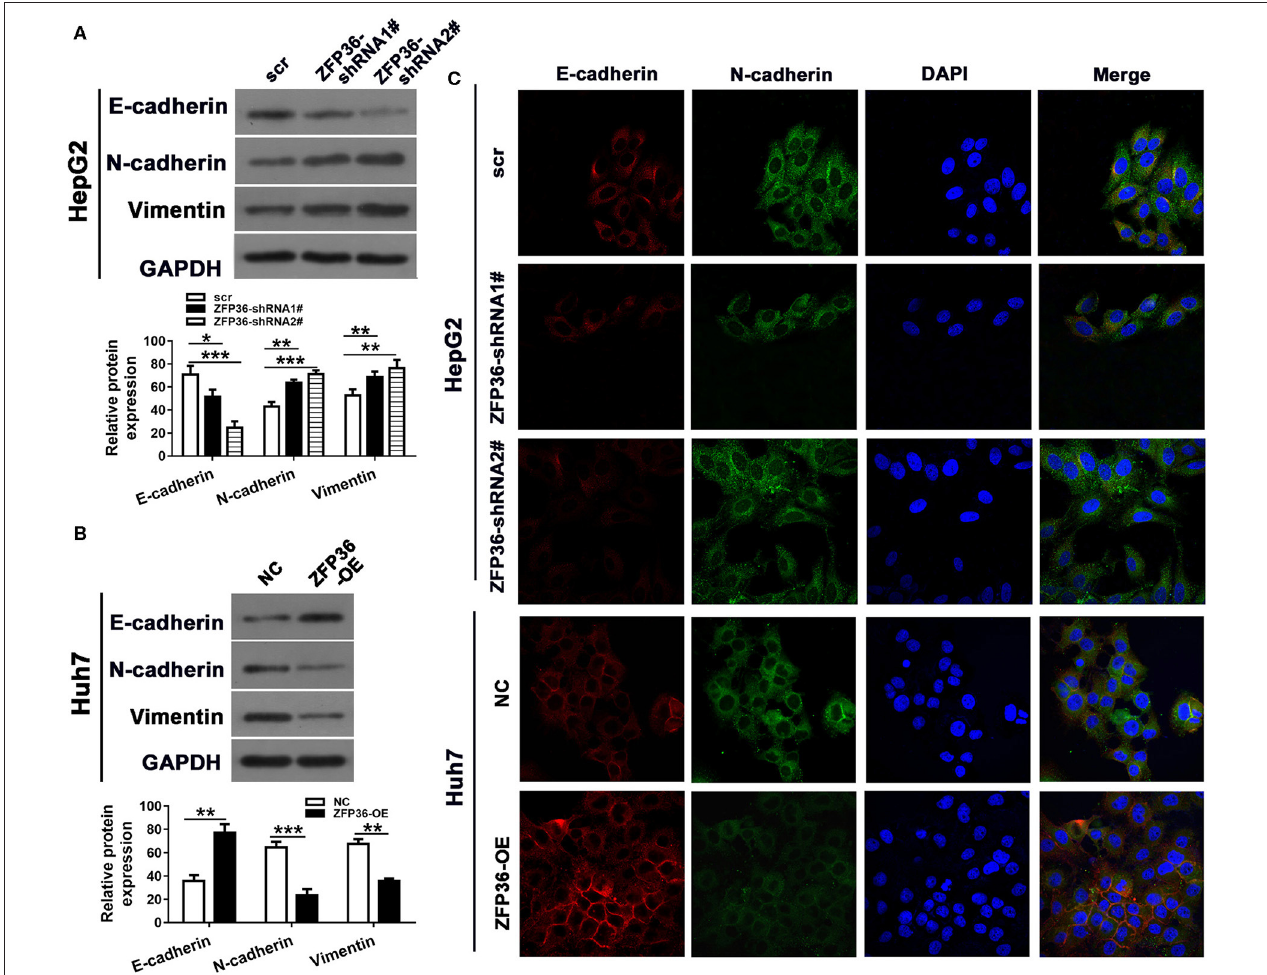
FIGURE 3 | ZFP36 regulates cell epithelial–mesenchymal transition (EMT). HepG2 cells were transfected with ZFP36-shRNA1# or shRNA2# and Huh7 cells were transfected with ZFP36-OE. (A,B) Levels of the EMT markers E-cadherin, N-cadherin and Vimentin were detected by western blots. (C) E-cadherin and N-cadherin expression was detected by immunofluorescence staining. * p < 0.05, ** p < 0.01, *** p <